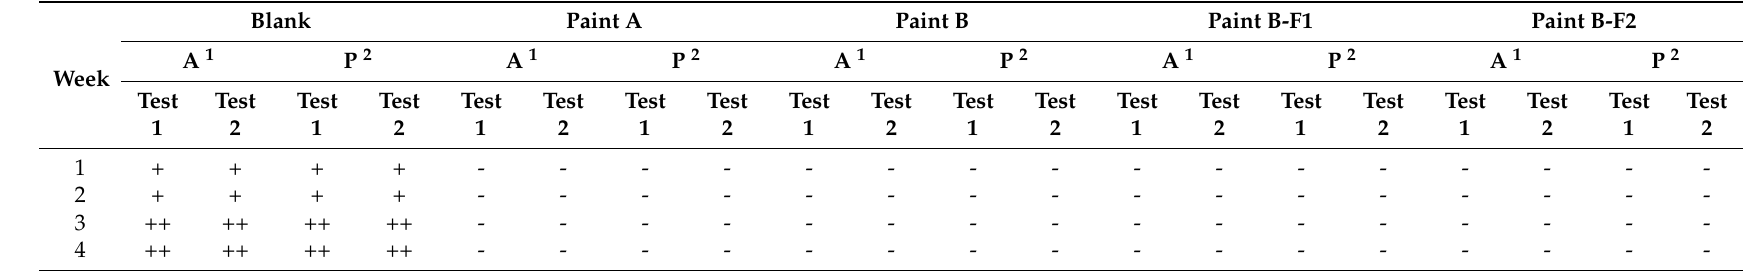
Table 3. Results from observation of molds